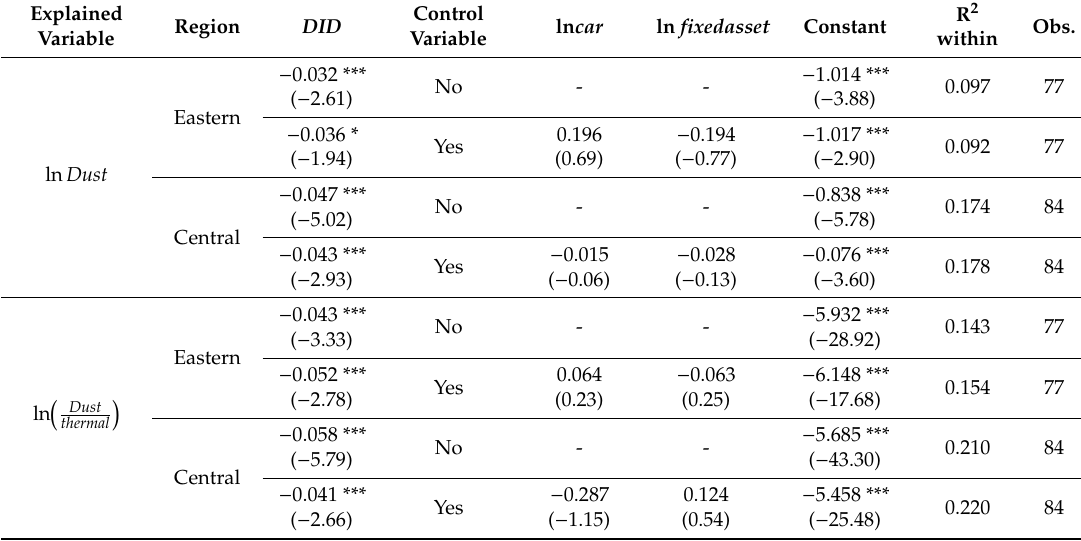
Table 6. Regression outcomes for the ULE reduction e ff ect on smoke